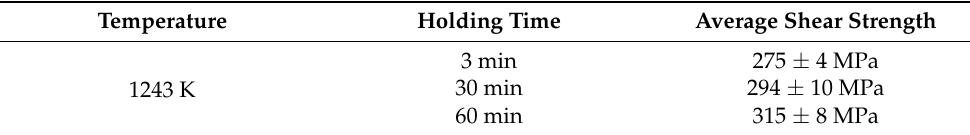
Table 3. Shear strengths of brazed joints for three brazing